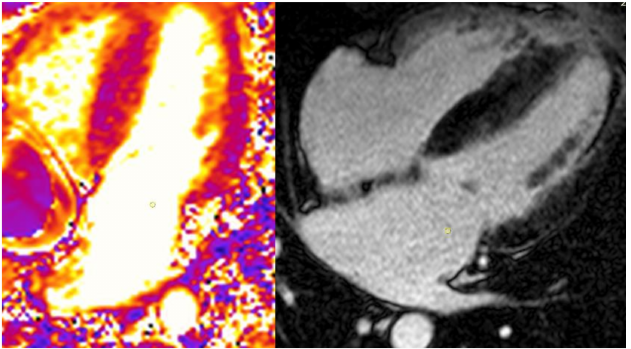
Figure 9. ( Left ) CMR T2 map with increased relaxation times representing oedema and inflammation within the myocardium in a patient with advanced Fabry cardiomyopathy; ( Right ) CMR LGE images with areas of LGE corresponding with areas of increased